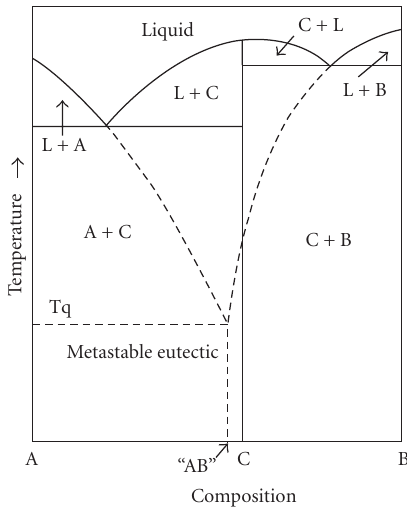
Figure 1: The hypothetical binary equilibrium phase diagram A-B showing the position of a (deep) metastable eutectic with a composition “AB” defined at the intersect of the metastable extensions of the liquidus surface (dashed lines) and located in between the compositions of both (stable) eutectic points on the liquidus surface at the top of the diagram (solid lines). This figure was modified after